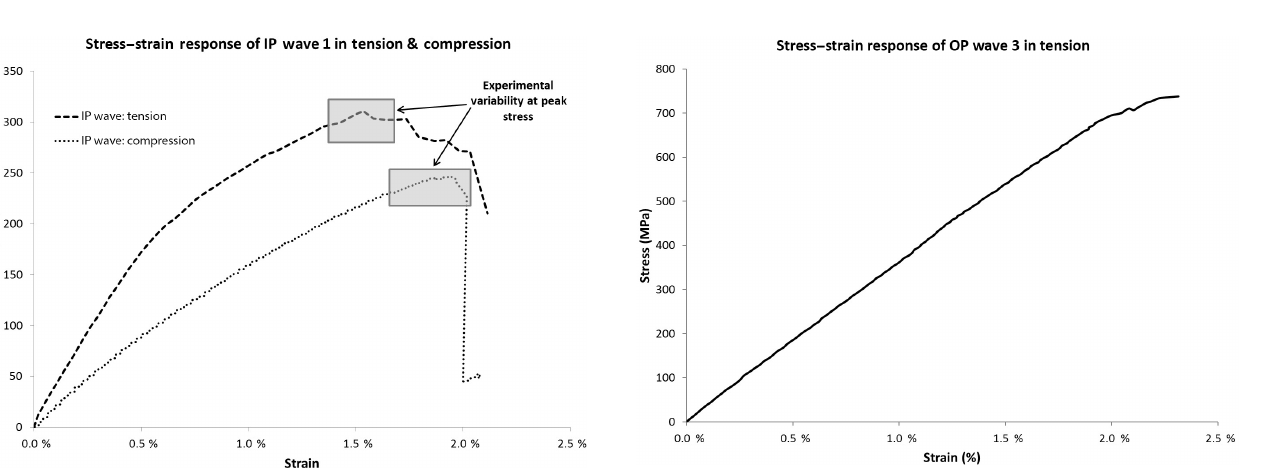
Figure 13. Stress–strain of OP wave 3 in tension utilized for initial OP wave model